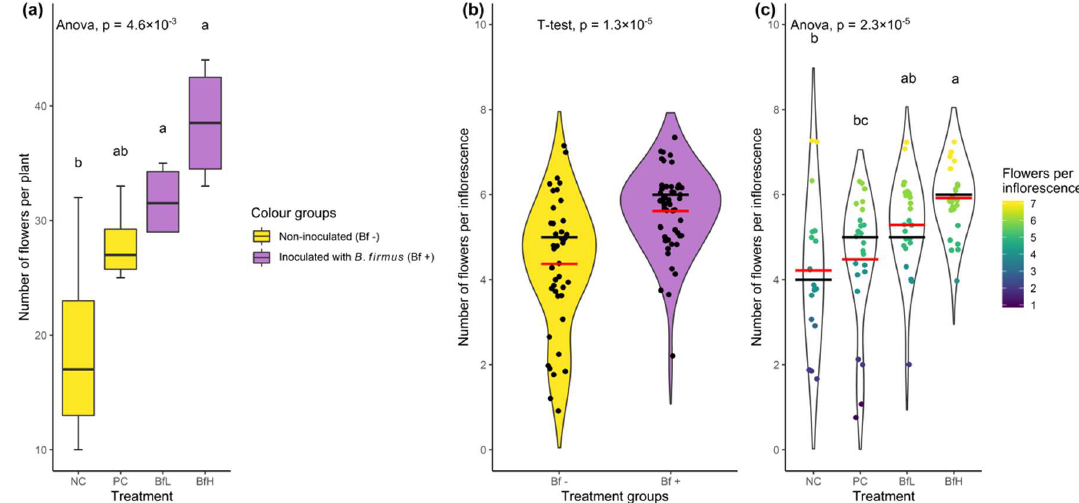
Figure 1. Data from the pot experiment showing the number of flowers per plant according to ( a ) treatment (dataset size, n = 16) and ( b ) the number of flowers per inflorescence in Bacillus firmus -inoculated/non-inoculated plants (n = 93), or ( c ) according to four tested treatments (n = 93). The numbers of flowers per plant are presented with the box plot and coloured according to the presence or absence of bacterial inoculum. Data for the number of flowers per inflorescence are presented with a violin plot with median (black bar) and mean values (red bar). The outline of the violin plot is a density function representing the underlying data frequency. Individual data points in the right-hand pane were coloured according to the number of flowers in each inflorescence (going from violet/blue representing smaller inflorescences to yellow for larger ones). Treatment means were separated using Tukey’s HSD ( a , c ) or a T-test ( b ). Means sharing a letter are not significantly different at p < 0.05. NC—